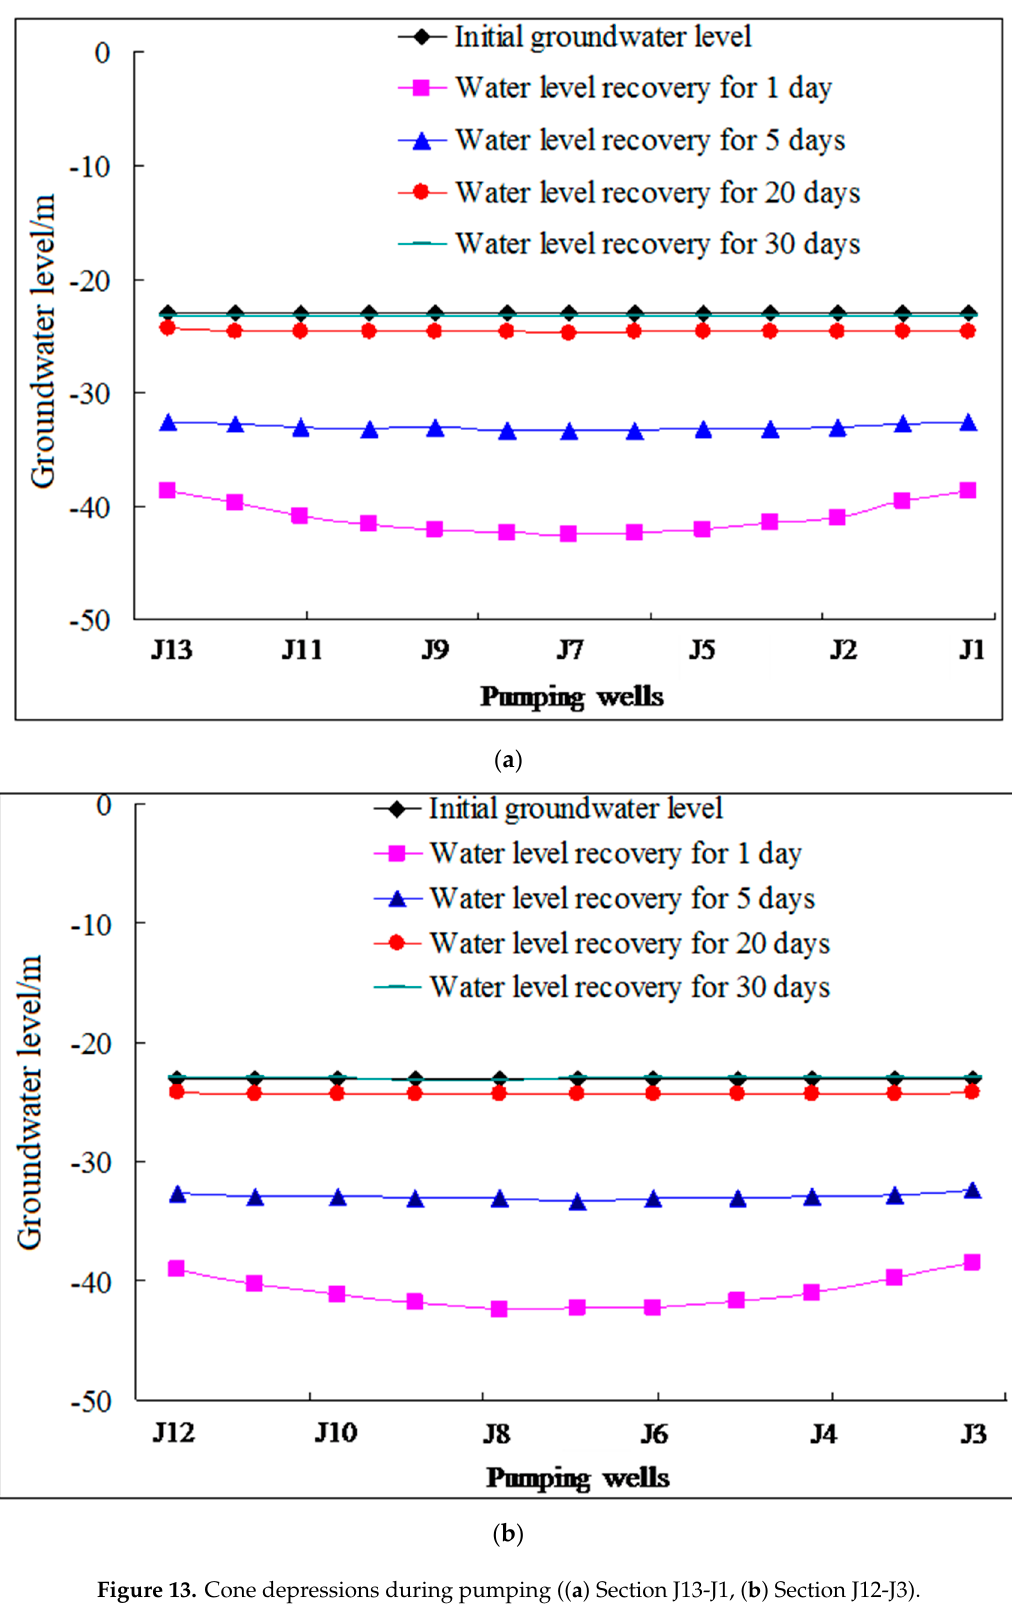
Figure 13. Cone depressions during pumping (( a ) Section J13-J1, ( b ) Section